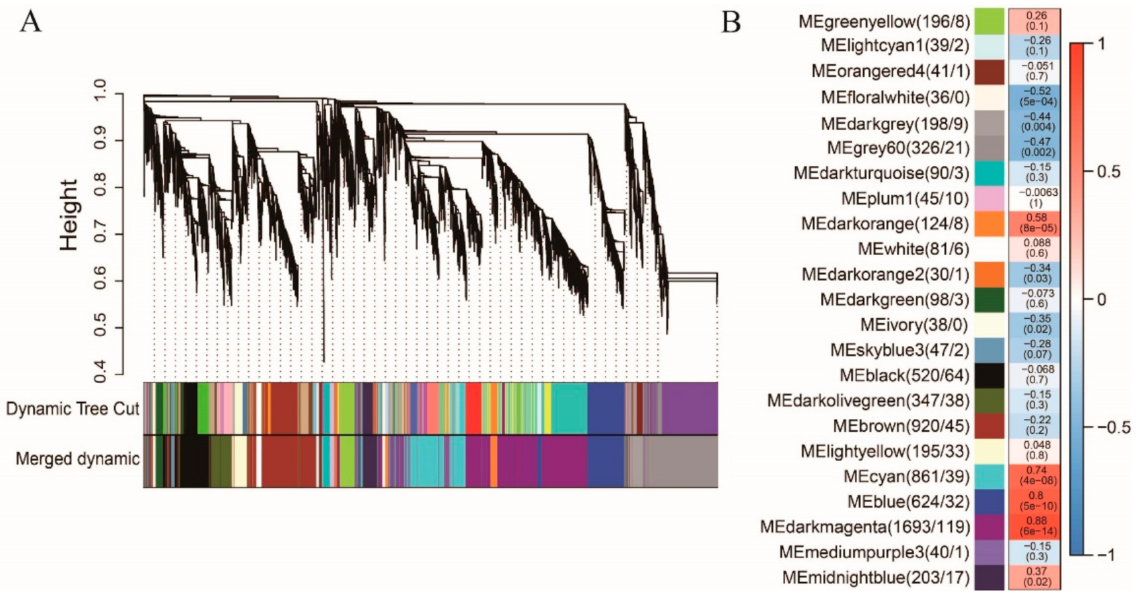
Figure 6. Co-expression network and correlations between module eigengene and sucrose content in peanut varieties. ( A ) Hierarchical clustering tree (dendrogram) of genes based on co-expression network analysis in ICG 12625 and Zhonghua 10. ( B ) Correlation analysis between expression pattern of genes in the 23 co-expression modules and sucrose content in two varieties. Boxes contained Pearson correlation coefficients and p values. The deeper red and blue color indicated that the ME of the module had more strong positive correlation and negative correlation with sucrose content, respectively. The number of genes/TFs in the module was provided on the